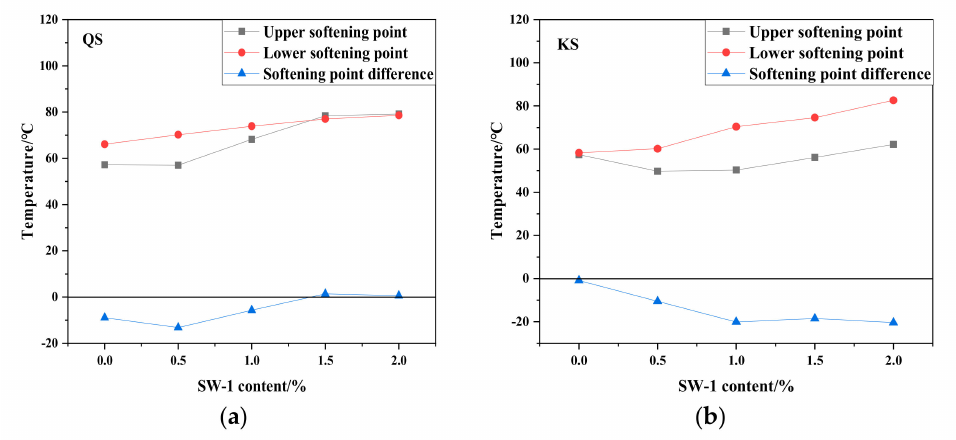
Figure 8. Effect of WS-1 content on storage stability of warm mixed rubber asphalt; ( a ) the storage stability of QS warm mix rubber asphalt; ( b ) the storage stability of KS warm mix rubber